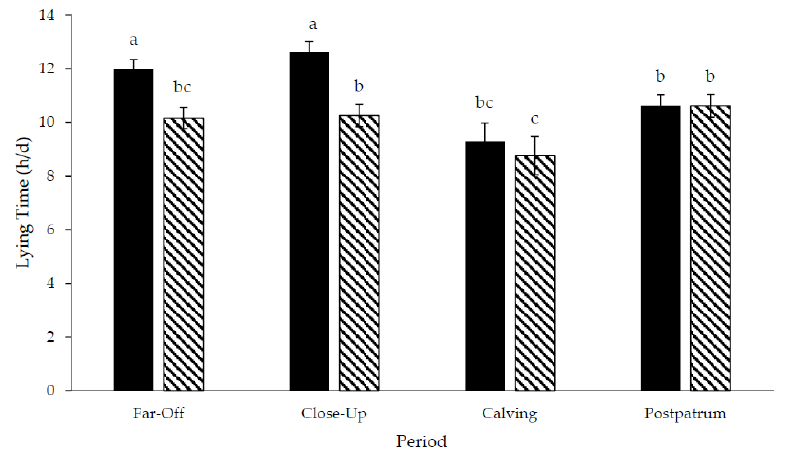
Figure 3. Lying time of Holstein cows managed in freestalls (solid bars; n = 14) or on pasture (striped bars; n = 14) during the dry period and early postpartum. Far-off: 60 to 15 d prepartum; close-up: 14 to 1 d